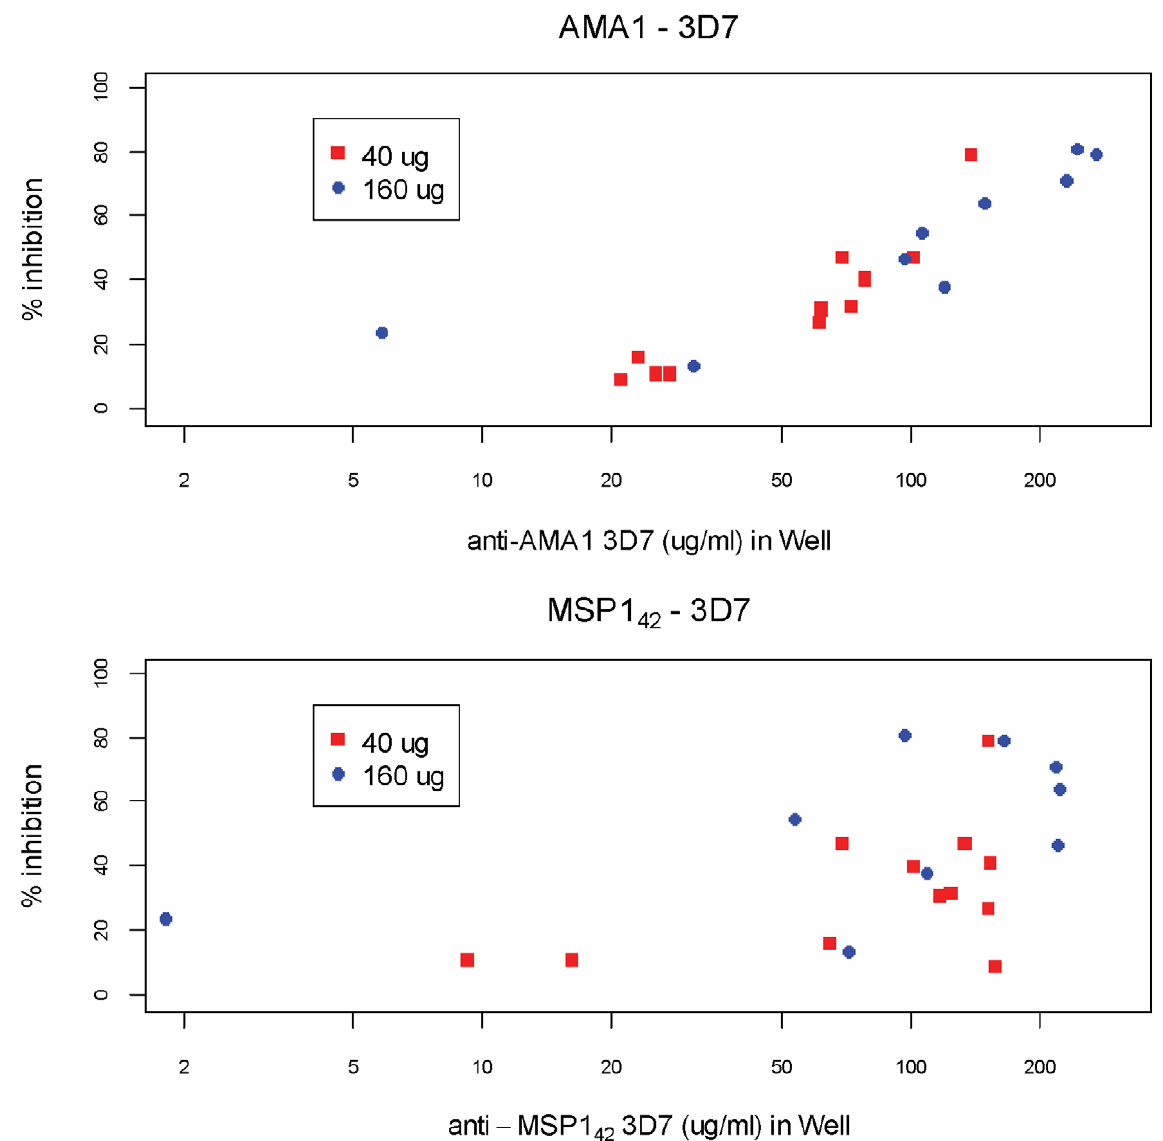
Figure 6. In vitro growth inhibition of homologous 3D7 parasites as a function of specific antibody concentration is shown. Purified IgG from Day 70 samples (two weeks after the second vaccination) were used at a concentration of 10 mg/mL.